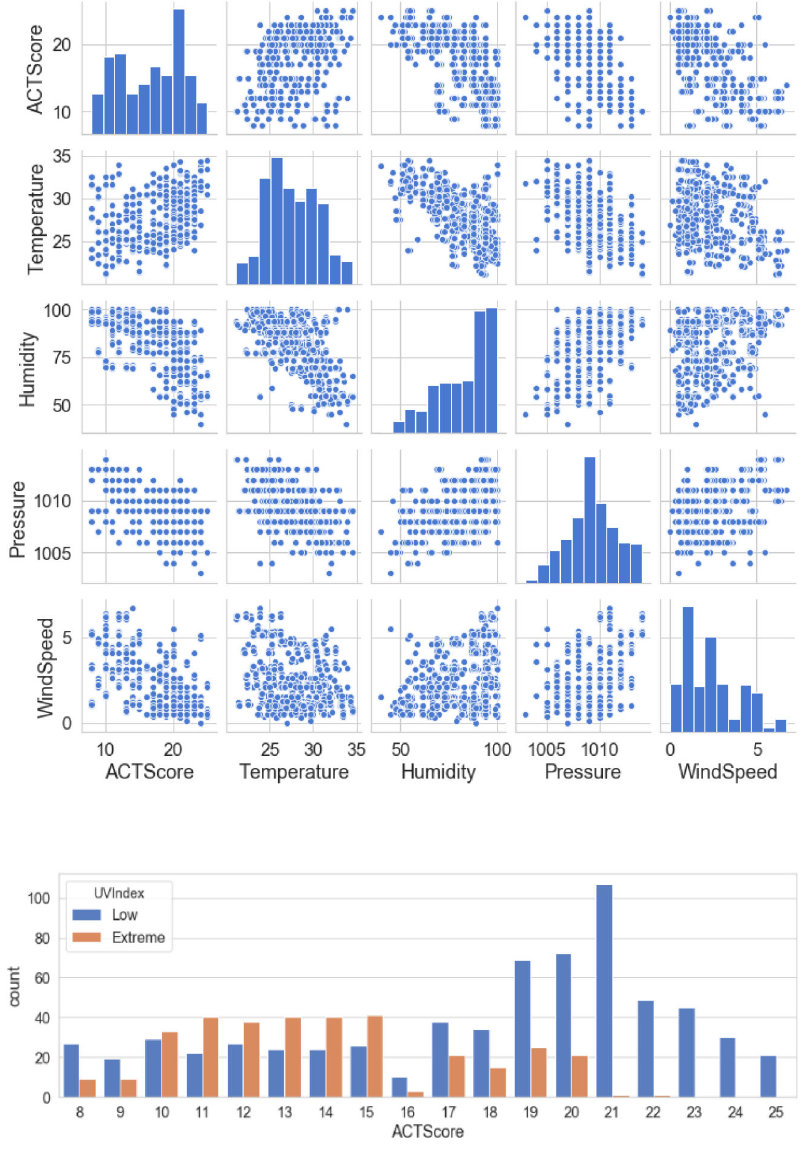
Figure 3. Weather visualisation.